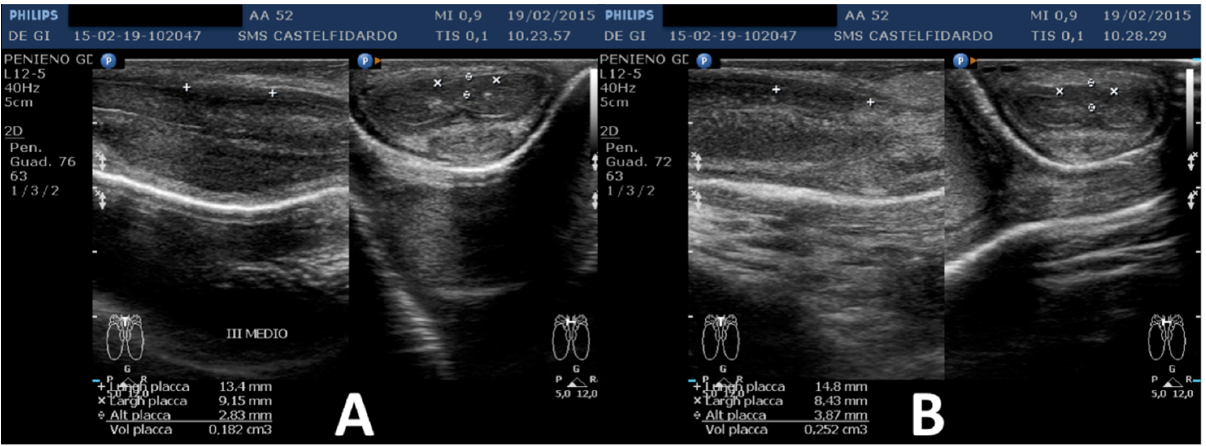
Figure 6. Ultrasonography of the penis and plaque measurement before treatment (longitudinal and transverse views). ( A ) First plaque, ( B ) second plaque.